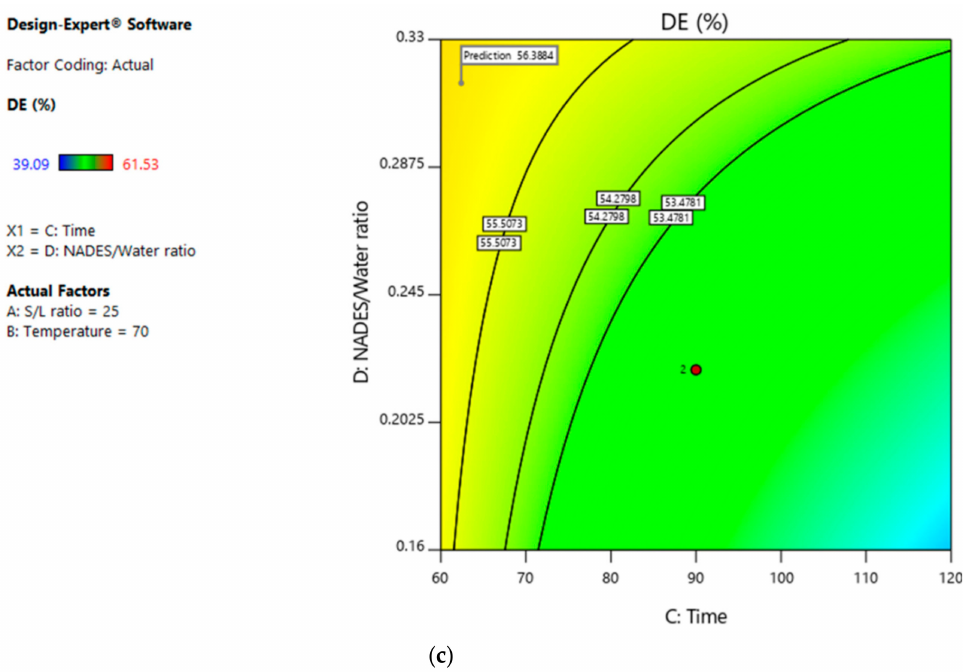
Figure 2. Contour maps of the pectin DE% with the significant interacting terms in ChCl–Glc–W. ( a ) Liquid / solid ratio vs. temperature; ( b ) liquid / solid ratio vs. NADES / water ratio; ( c ) time vs. NADES / water